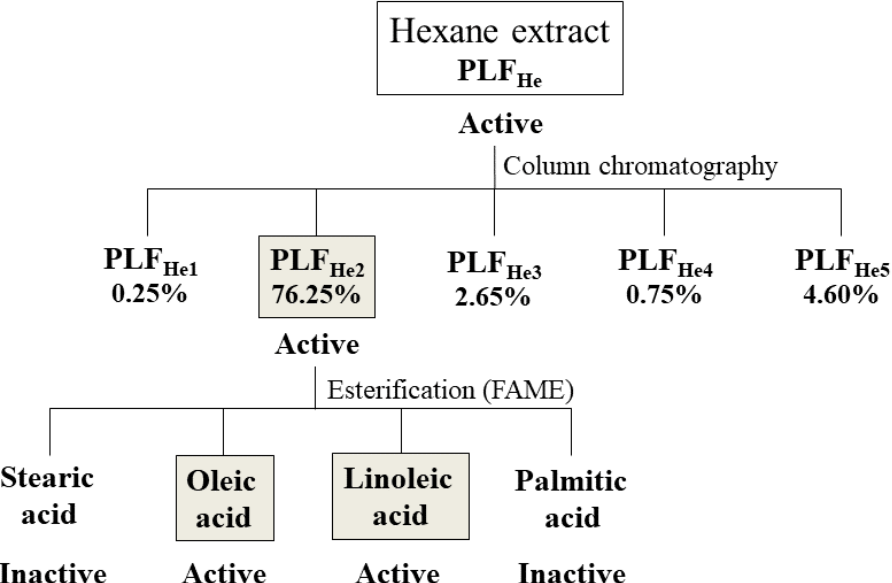
Figure 2. Overview of the purification process of the hexane extract of P. lentiscus fruits (PLFHe) and the respective insecticidal activity of each fraction or constituent on L. botrana larvae.